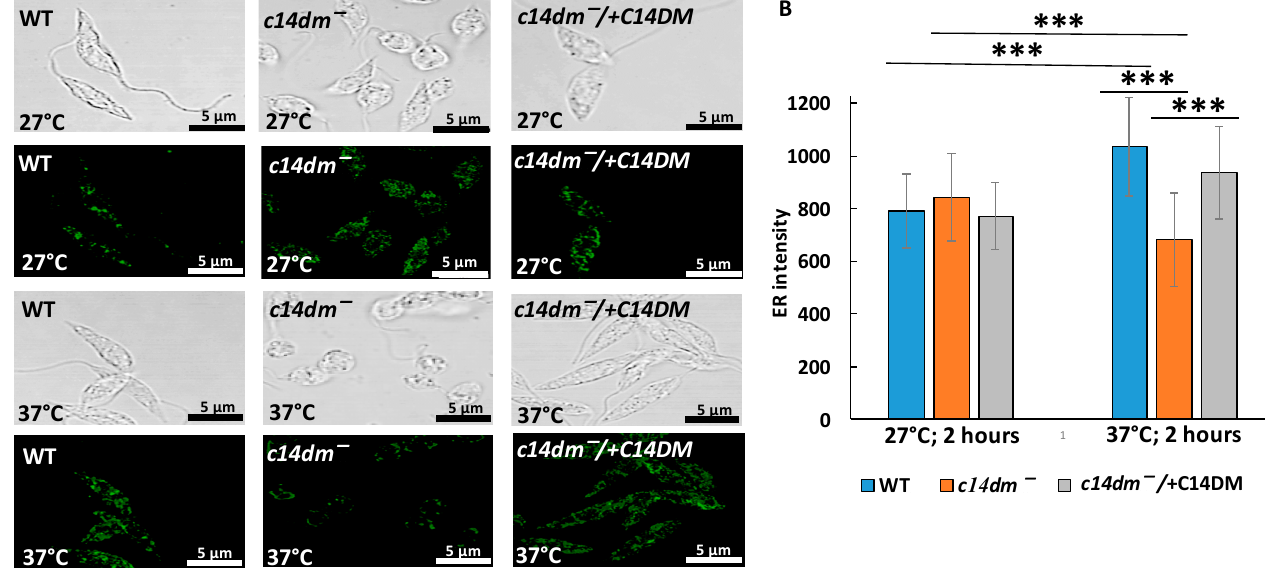
Figure 9. Heat treatment leads to a significant reduction in ER staining in c14dm − . ( A ) Representative images of WT, c14dm − and c14dm − / + C14DM cells are shown. BiP staining was performed after 2 h of incubation at 27 or 37 ◦ C. ( B ) Quantitative analysis of BiP-staining intensity. ***: p < 0.001.